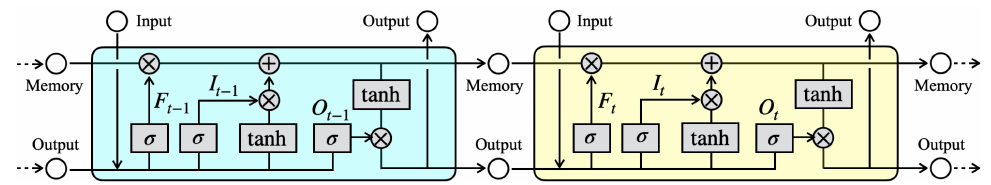
Figure 18. LSTM network architecture of the hidden layer. Signals progress from left to